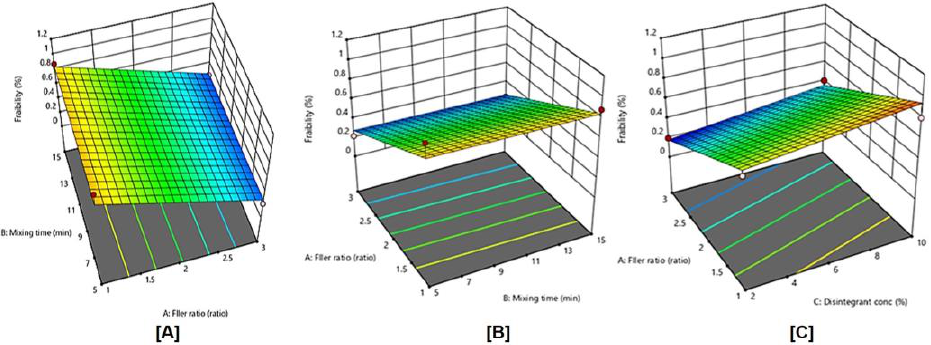
Figure 6. Influence of independent variables on tablet friability (Y2) with significance ( A ) p value = < 0.0001, ( B ) p value = 0.7640, and ( C ) p value < 0.0097